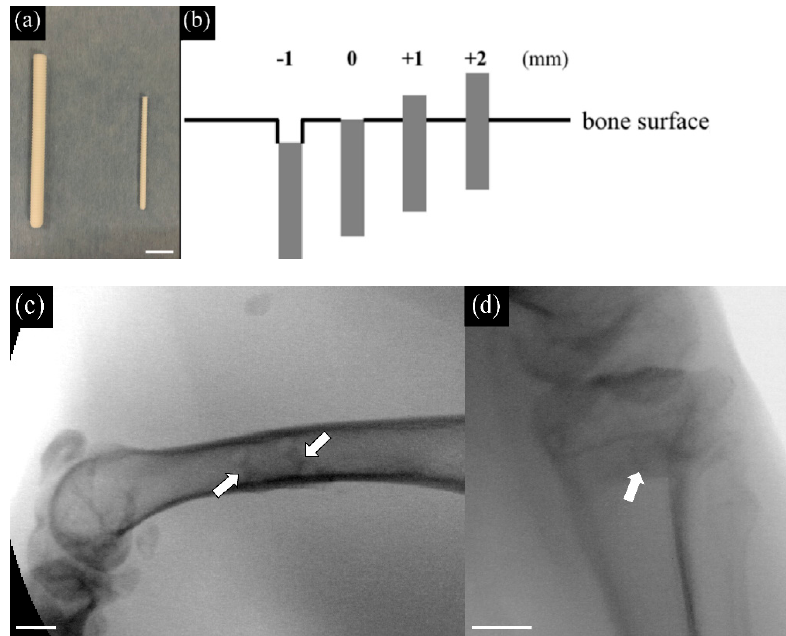
Figure 1. HA-PLLA threaded pins, their insertion height, and X-ray photographs. Left to right: ( a ) HA-PLLA threaded pins (diameter 4.5 and 2.0 mm). Scale bar: 10 mm. ( b ) Insertion height determined based on bone surface. ( c ) The X-ray photograph of inserting threaded pins of 2.0 mm into the lateral midshaft of the femur. Scale bar: 10 mm. ( d ) The X-ray photograph of inserting a threaded pin of 4.5 mm into the proximal medial tibia. Arrows indicate the inserted pins. Scale bar: 10 mm.